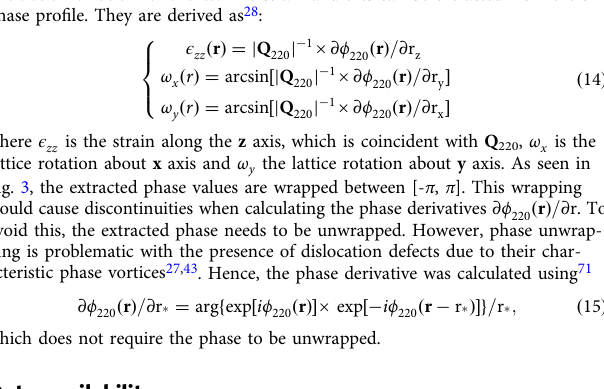
algorithm with Gaussian noise model 34 . The whole inversion is performed on a NVDIA high power computer (4 GPUs) and requires about 24 h to run. For the reconstruction using a known, fi xed probe, we followed the same procedures as above, except that the probe was not updated, and the angular